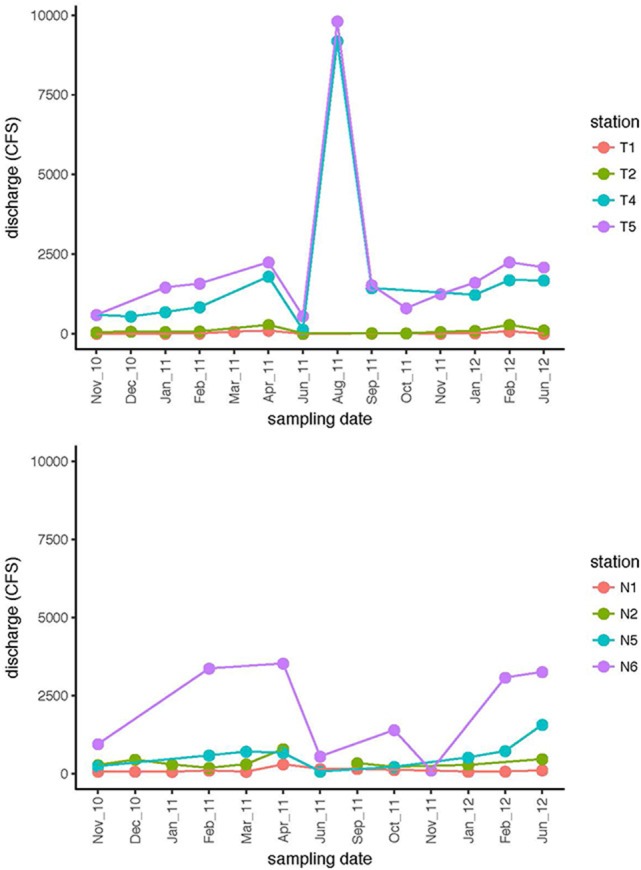
Discharge (cubic feet per second) at four stations in the Tar-Pamlico River and the Neuse River on dates when samples were collected. Filled circles are from the dates at which samples were collected; lines connect consecutive sampling dates.